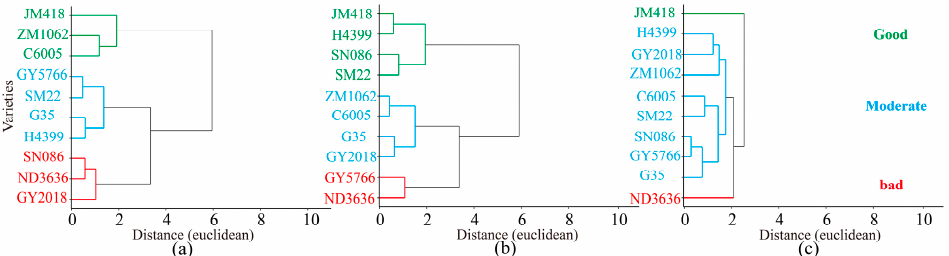
Figure 9. Dendrogram of wheat genotypes based on UAV thermal imagery extracted canopy tem- perature (all of the stages) at different water treatments: ( a ) W0, no irrigation during the growing season, ( b ) W1, irrigation at jointing, ( c ) and W2, irrigation at jointing and anthesis. Among them, three kinds of colors represent canopy temperature categories.